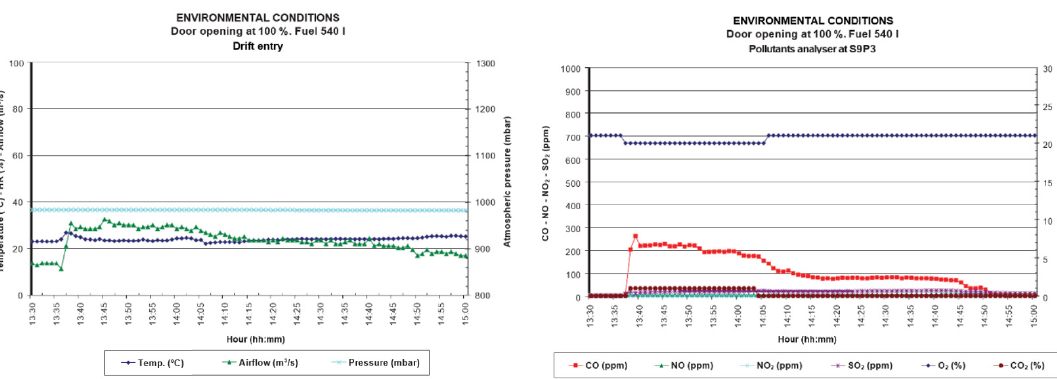
Figure 9. Evolution of the environmental conditions over time; test 5.